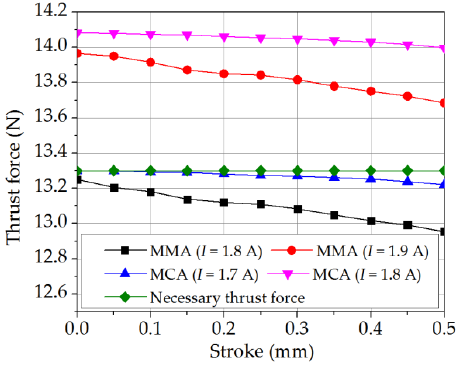
Figure 14. Minimum excitation current for MCA and MMA models (no return spring).